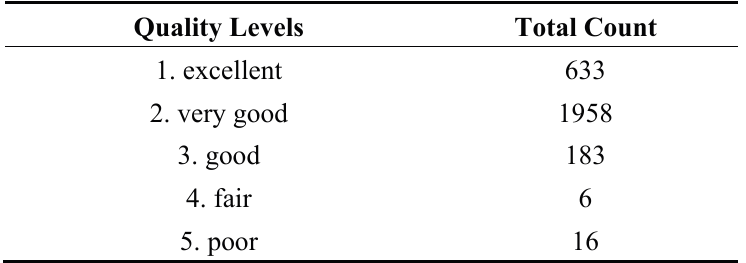
Table 3. NFIQ defined qualities for 2796 collected